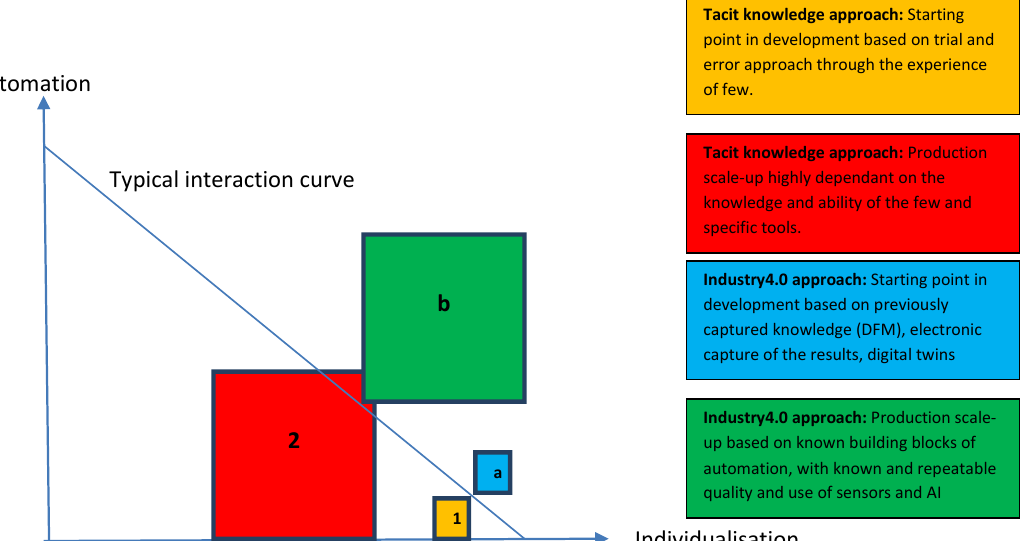
Figure 8. Manufacturing perspective for Composite